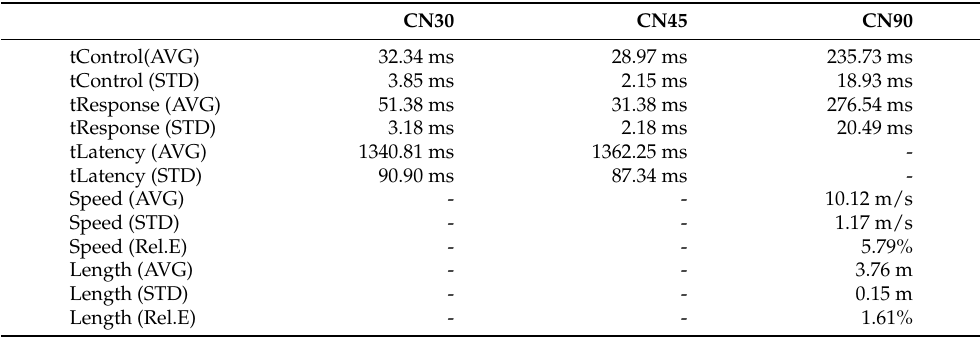
Table 2. Results obtained from two control nodes (CN30 and CN45) sending raw data to the third module